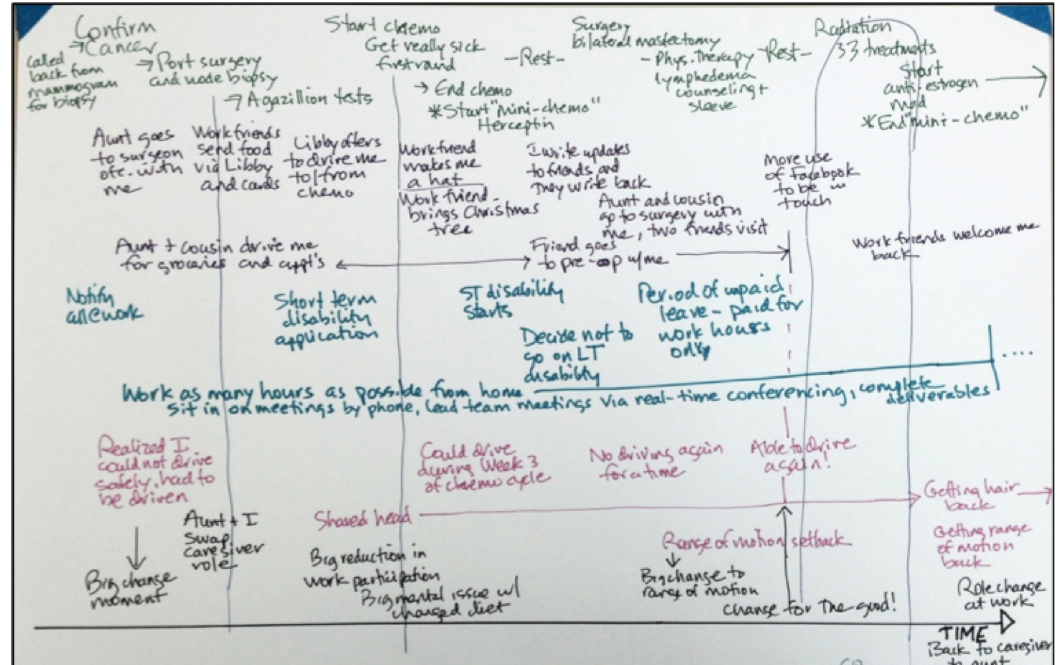
Figure 1. A sample cancer journey